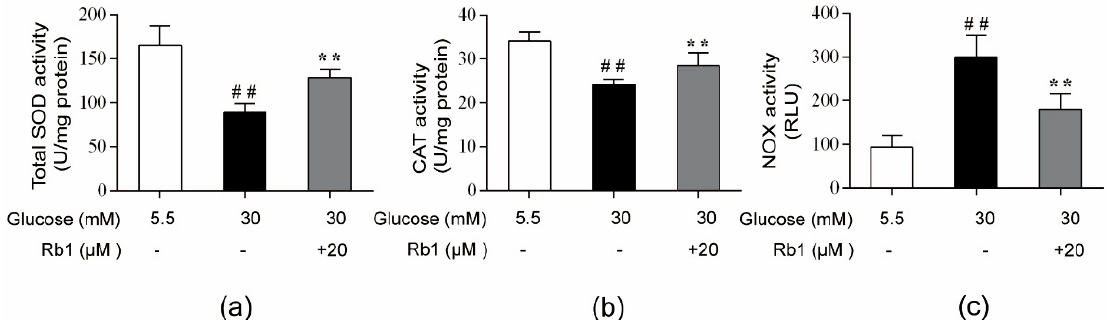
Figure 5. Effects of Rb1 on the activity of nicotinamide adenine dinucleotide phosphate (NADPH) oxidase (NOX) and antioxidant enzymes in RCECs exposed to high glucose. ( a ) and ( b ) The activity of superoxide dismutase (SOD) and catalase (CAT) was evaluated with an enzymatic colorimetric method. ( c ) The activity of NOX was measured with the chemiluminescence method. The data are expressed as the means ± SD. ## p < 0.01 versus 5.5 mM glucose; ** p < 0.01 versus 30 mM glucose.